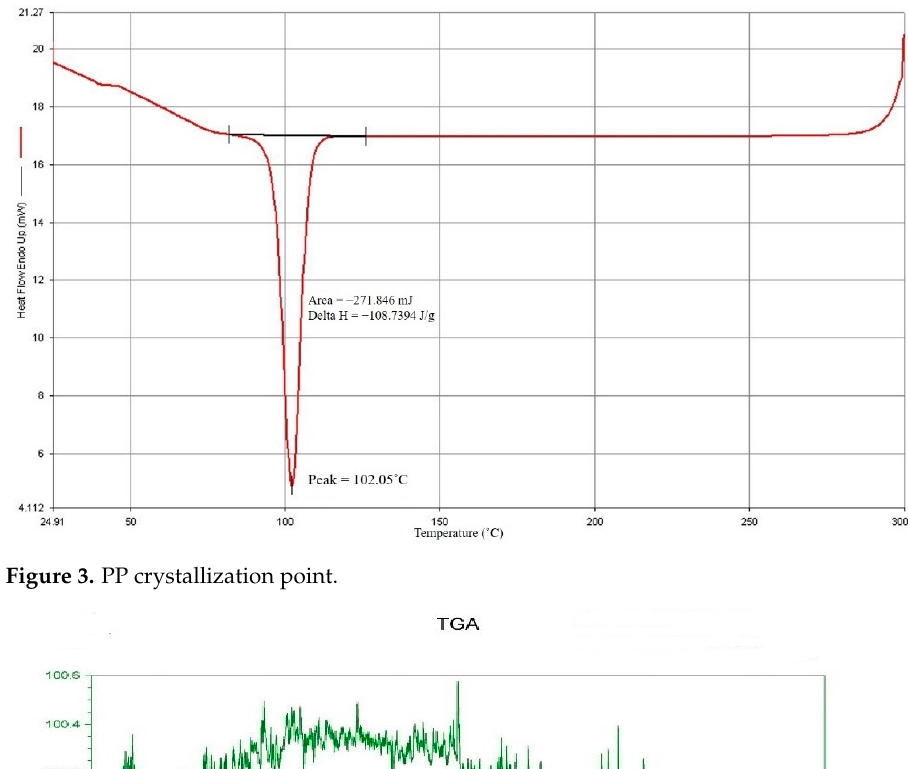
Figure 3. PP crystallization point.